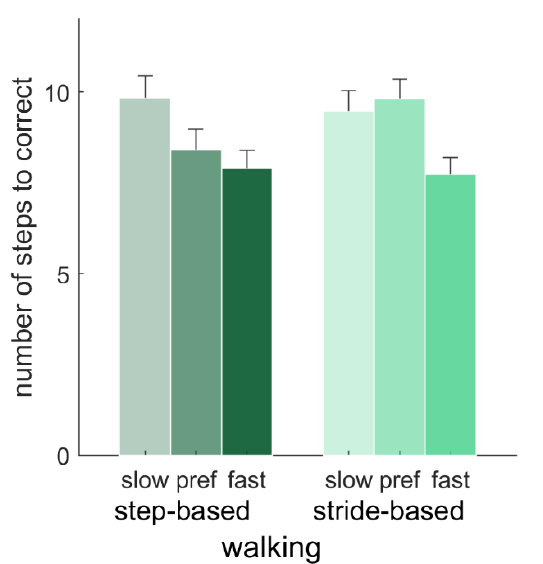
Figure 7. Average number of steps needed to correct after perturbations in walking ( N = 12). Error bars represent the standard error of the mean.